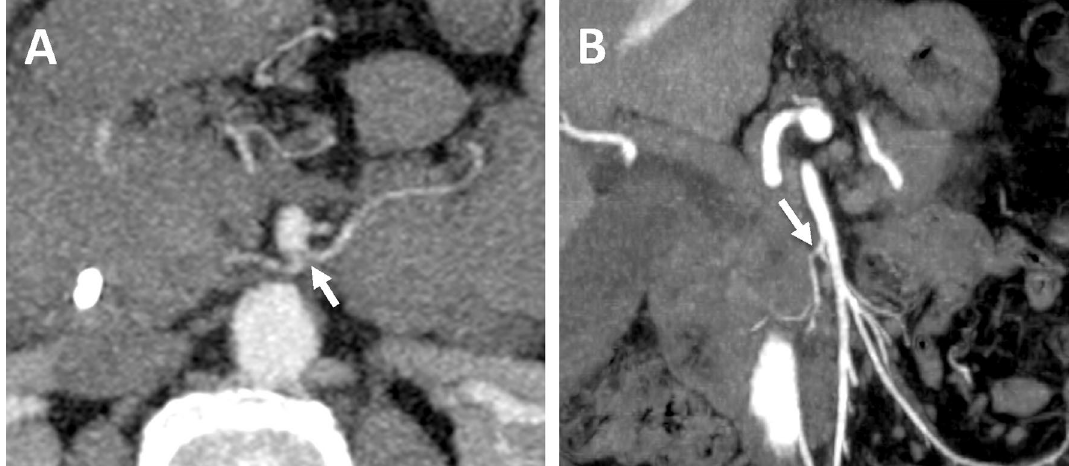
Figure 1. CT-examinations of two different patients with adenocarcinoma of pancreatic head obtained with intravenous contrast material. ( A ) Axial MIP-image in arterial phase shows the common origin of inferior posterior pancreatoduodenal artery and first jejunal branch (arrow), arising from superior mesenteric artery ( B ) oblique coronal MIP-image shows inferior pancreatoduodenal artery and its branches with its common origin with the first jejunal branch